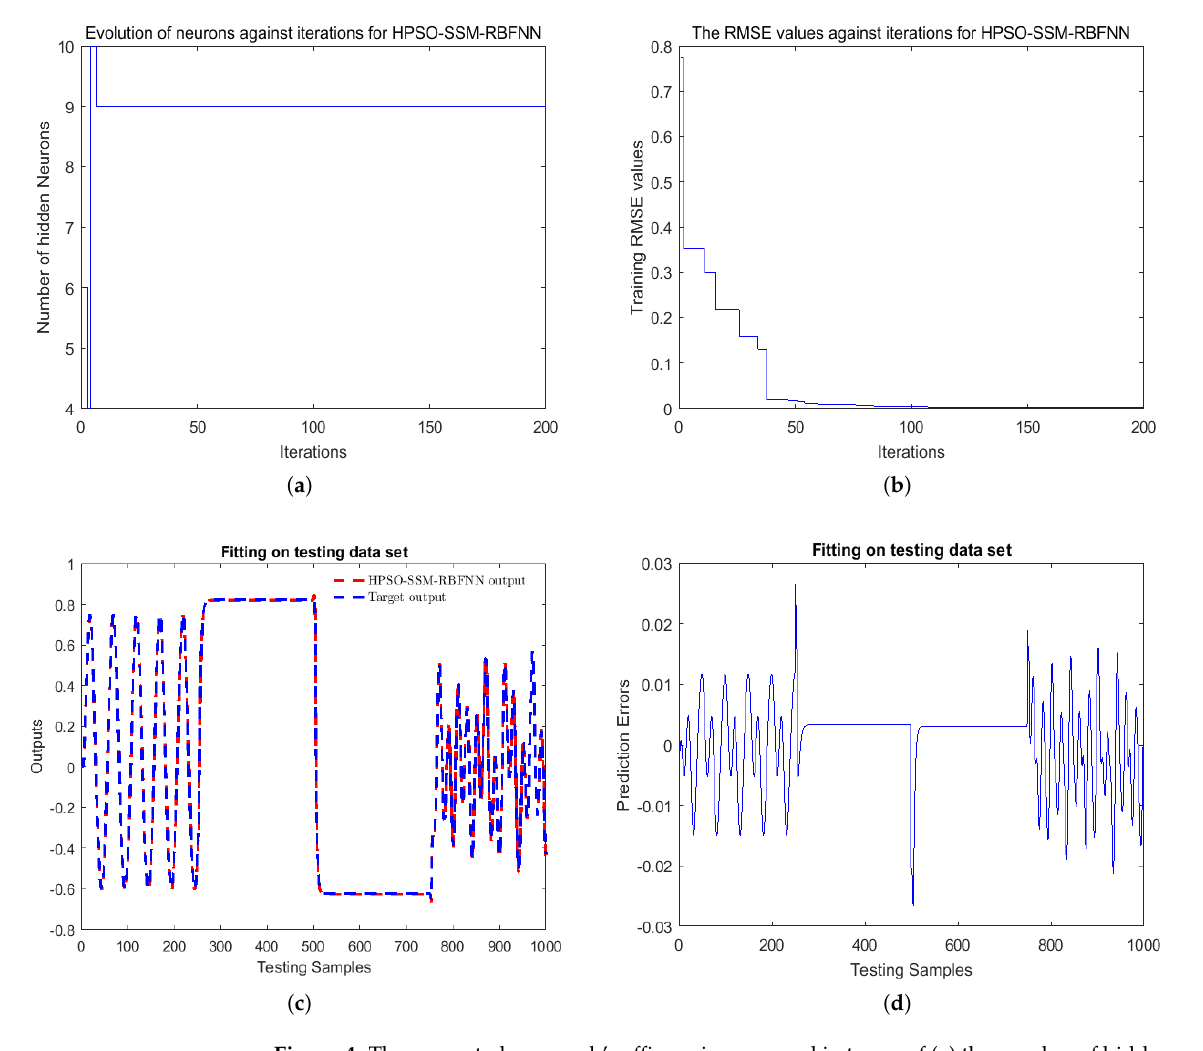
Figure 4. The presented approach’s efficacy is measured in terms of ( a ) the number of hidden neurons during training, ( b ) RMSE values in the training phase, ( c ) the predicted results by HPSO-SSM- RBFNN during the testing phase, ( d ) prediction errors during the testing